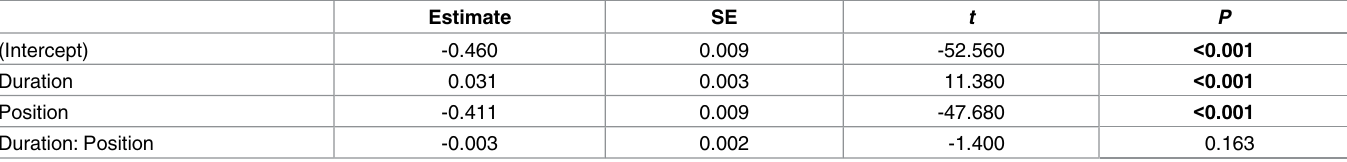
Table 2. Estimates, standard errors (SE), t -values and P -values for fixed effectsin GLMM testing the effects of deployment duration (number of days) and position (inner or outer area of a bay) on daily sediment flux (g m -2 d -2 ). Randomintercepts were allowedper site (bay). Estimates are in log units. Significantdifferences (P < 0.05) are denotedin bold.